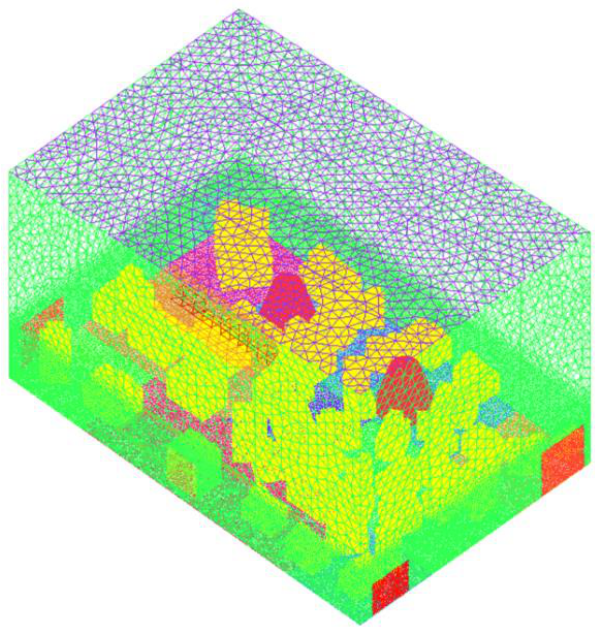
Figure 8. Grid division of broiler chamber with yellow-feathered broilers in ICEM CFD.